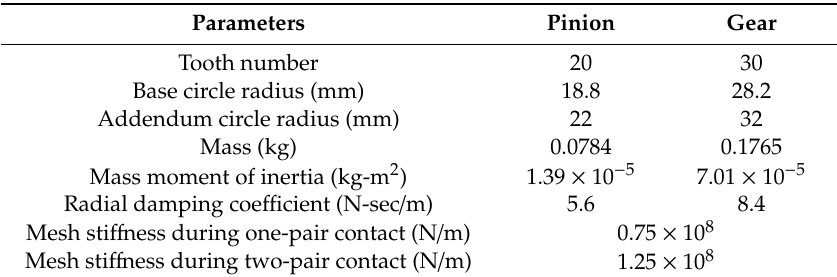
Table 1. Spur gear pair